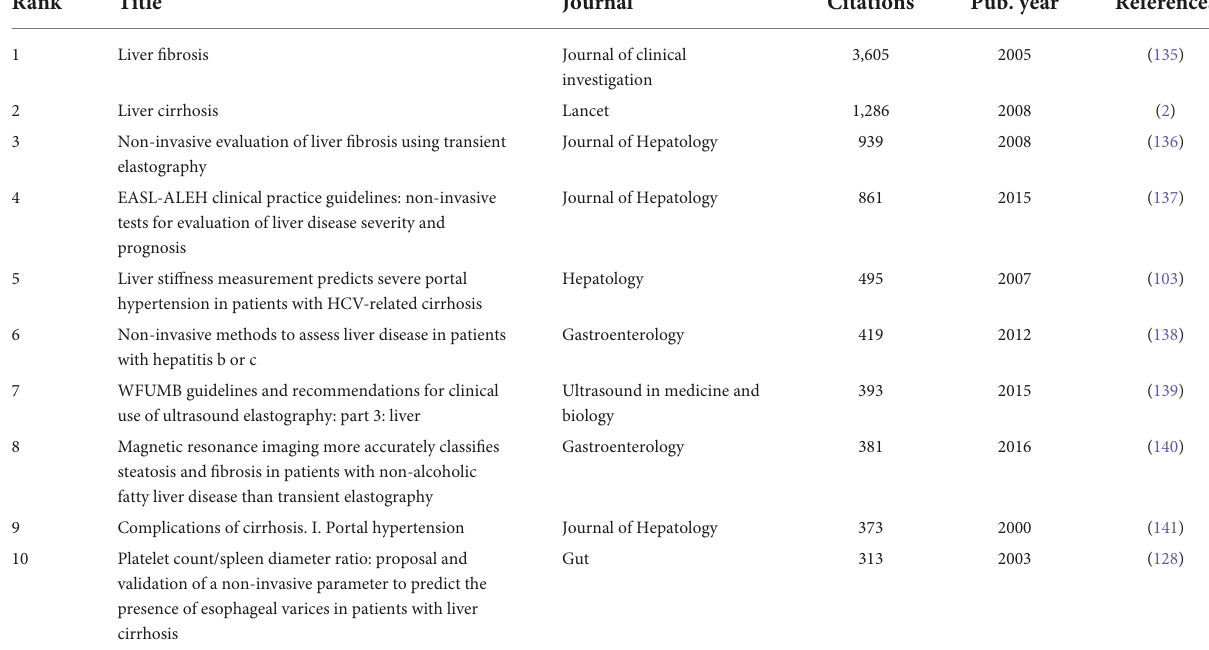
TABLE 2 Top 10 high-cited